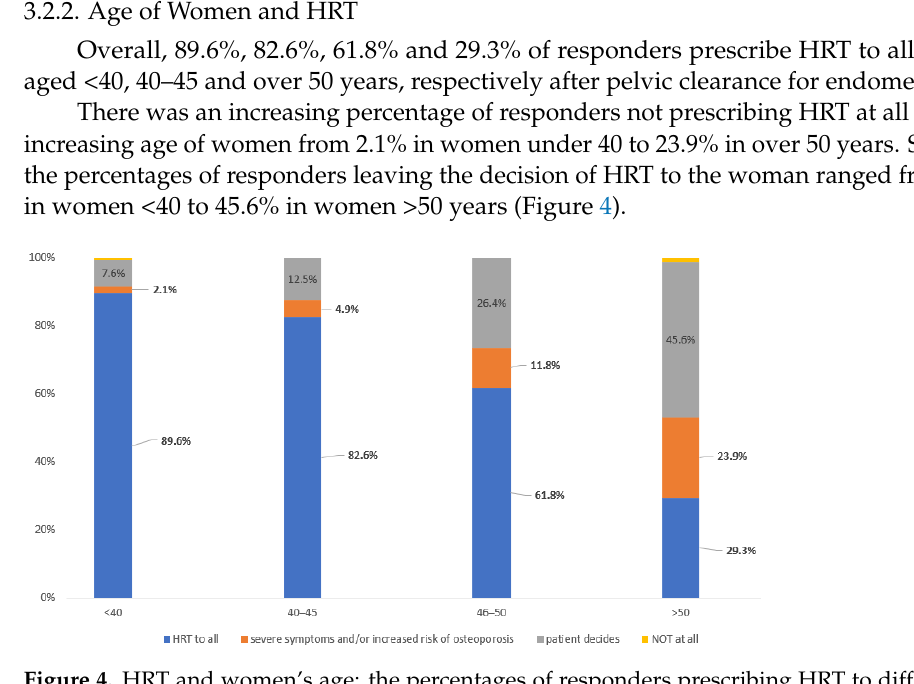
Figure 4. HRT and women’s age: the percentages of responders prescribing HRT to different age groups after surgical menopause in women with endometriosis. groups after surgical menopause in women with